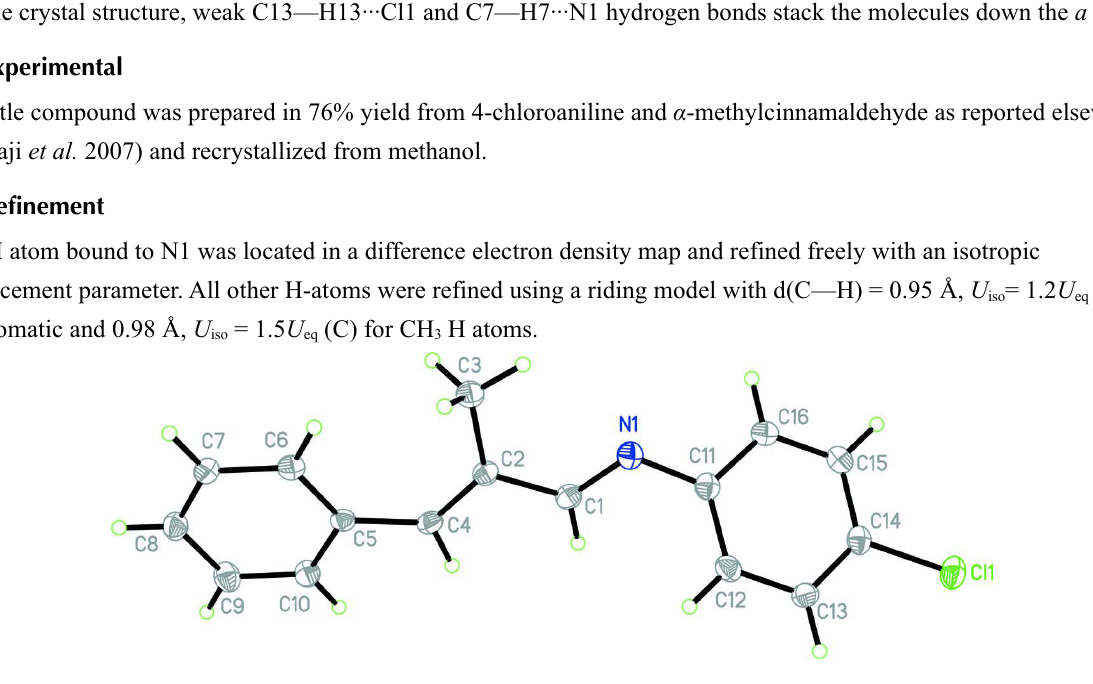
Figure 1 The structure of (I) with displacement ellipsoids for the non-hydrogen atoms drawn at the 50% probability